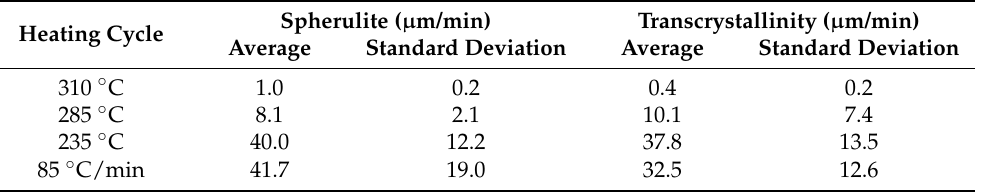
Table 1. Growth rate data measured from microscopy videos for spherulites and transcrystallinity regions.